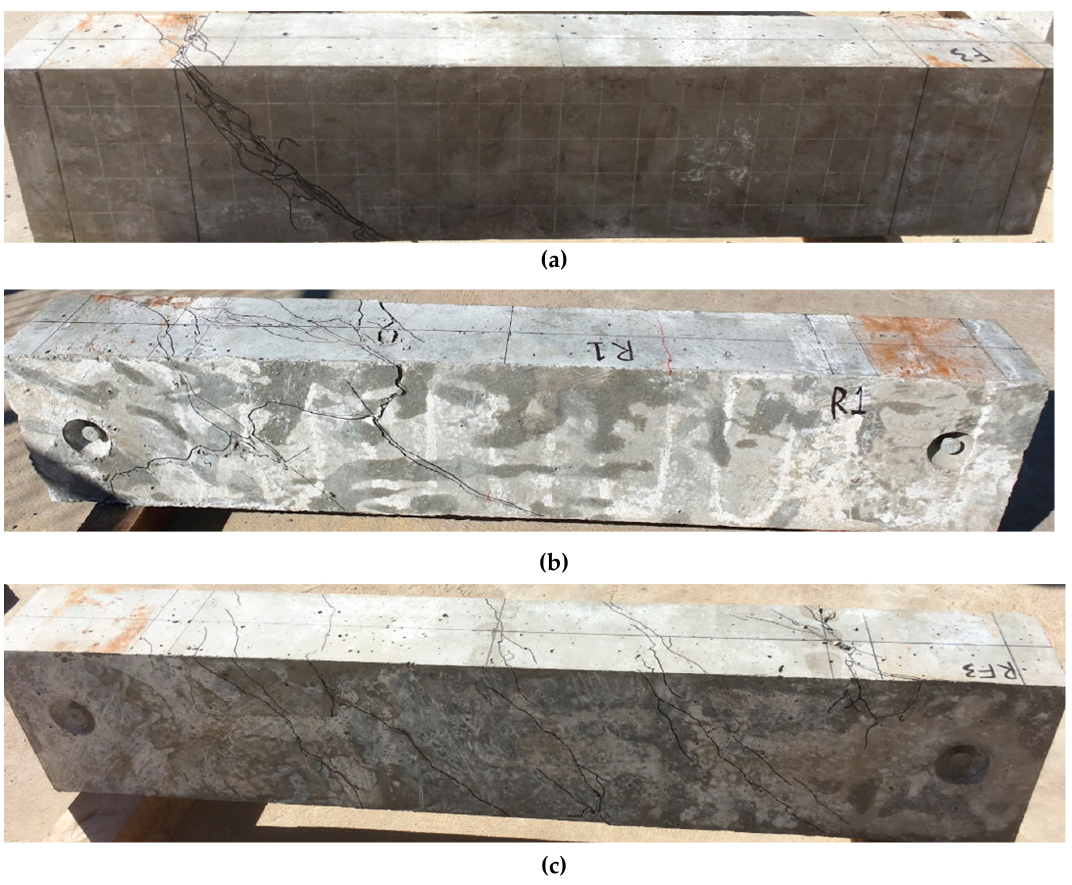
Figure 5. Photographs of the crack patterns based on reinforcement types: ( a ) fibre only reinforcement; ( b ) conventional reinforcement only; and, ( c ) hybrid fibre and conventional reinforcement.